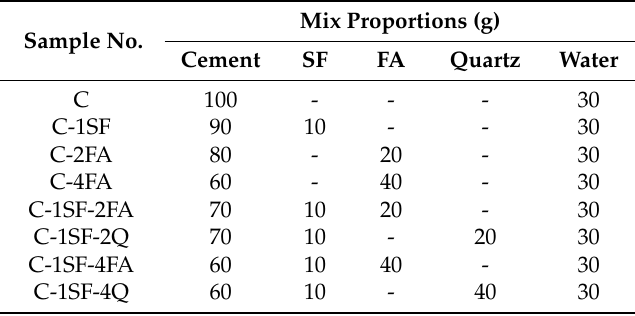
Table 2. Mix proportions of cement pastes.